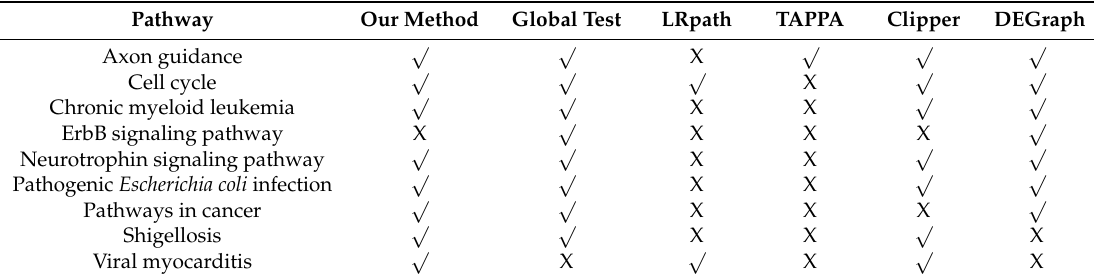
Table 2. Identification results of the nine BCR/ABL1-involved pathways by our methods and previous methods for the ALL